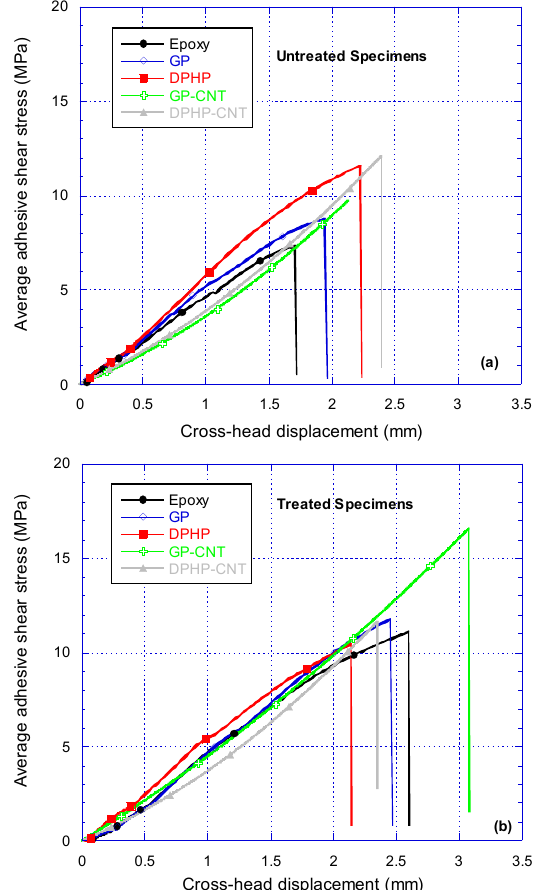
Figure 8 . Single lap joint shear tests on joints made with ( a ) untreated and ( b ) treated adherends for various nanocomposite systems.